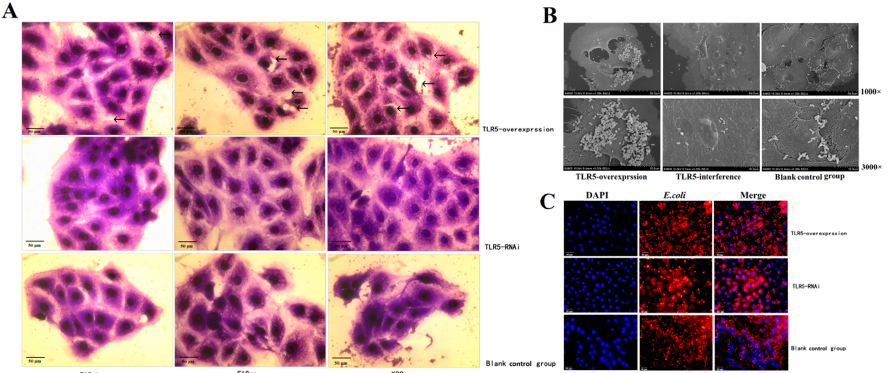
Figure 5. Evaluation of E. coli adhesion to IPEC-J2 cells. ( A ) Results of Gram staining. Cells were observed under an optical microscope (400×). Arrows represent where the cells were damaged. ( B ) Results of scanning electron microscope (SEM). Cells were observed under a scanning electron microscope (1000× and 3000×). ( C ) Results of indirect immunofluorescence. Blue fluorescence represents nucleus stained by DAPI; red fluorescence represents cytoplasm and cell membrane combined with E. coli antibody. Cells were observed under a fluorescence microscope (100×).